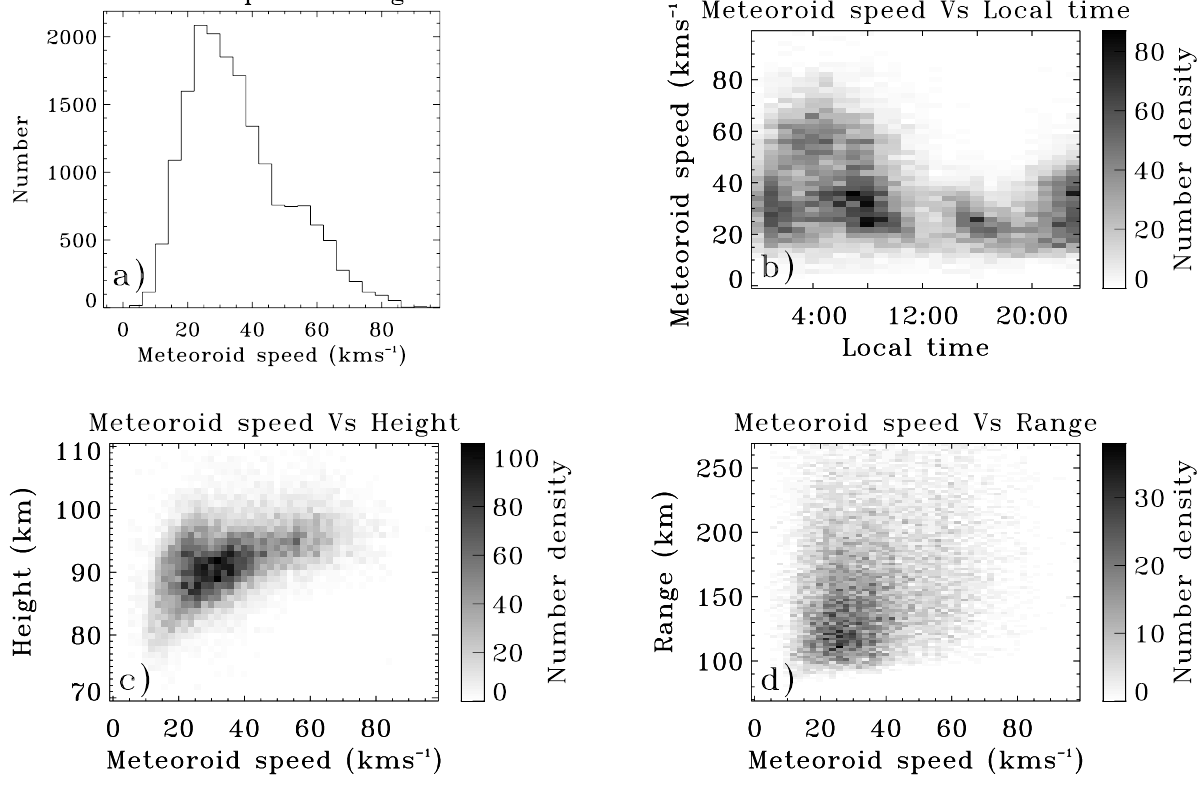
Fig. 7. Meteoroid speed estimates obtained using the BP meteor radar between 15th and 19th of January 2004: (a) histogram of meteoroid speeds, (b) image density plot of meteoroid speeds vs. local time, (c) image density plot of meteoroid speeds vs. height, (d) image density plot of meteoroid speeds vs.